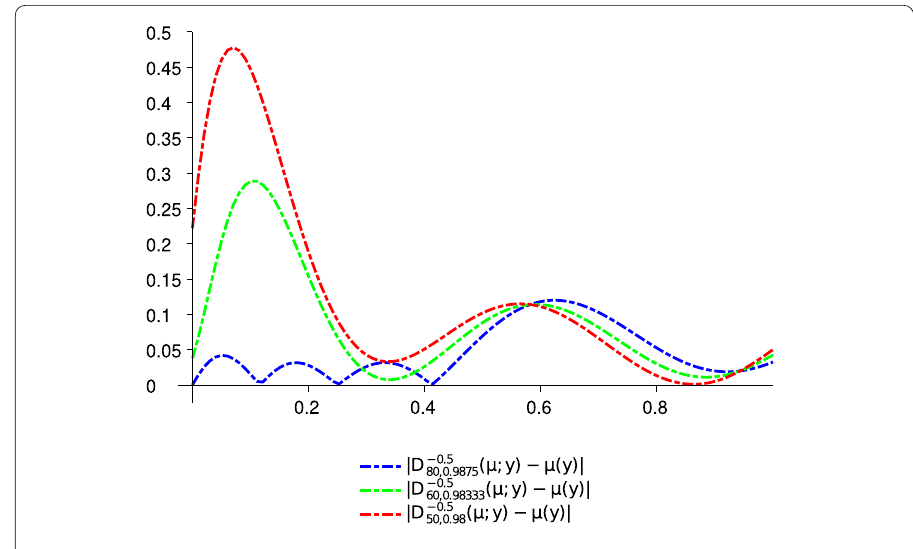
Figure 6 The error of approximation D –0.5 m , q ( μ ; y ) to μ ( y ) for fixed values of q and